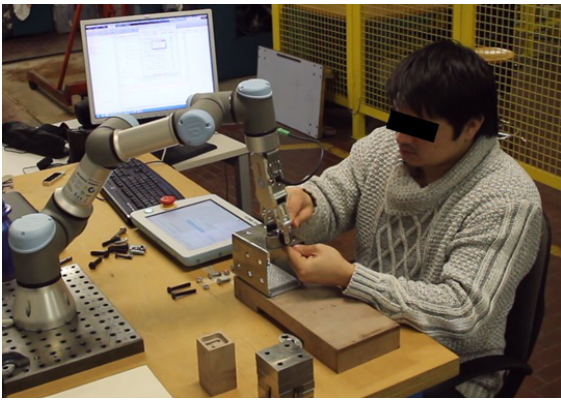
Figure 3. Experimental setup